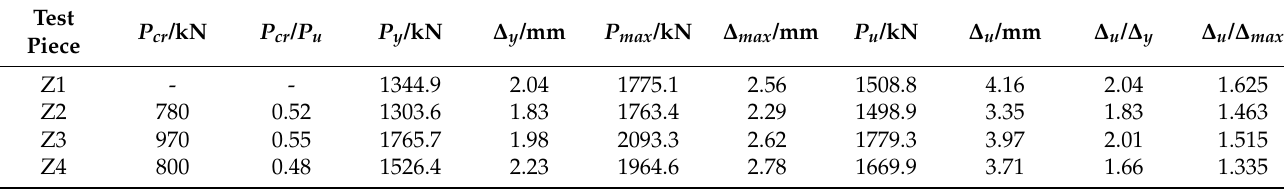
Figure 9. Comparison of load–displacement curves. Table 4. Load and displacement eigenvalues.